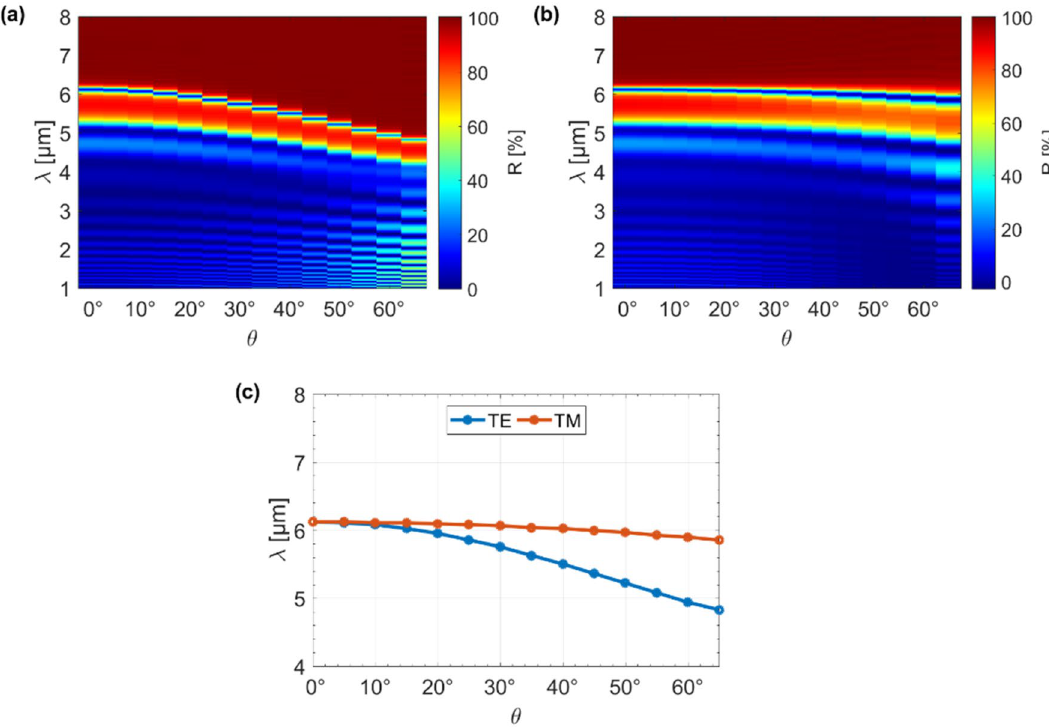
Figure 7. Angular reflection spectra for ( a ) TE and ( b ) TM polarized waves, together with the ( c ) reflection dip spectral position for different incidence